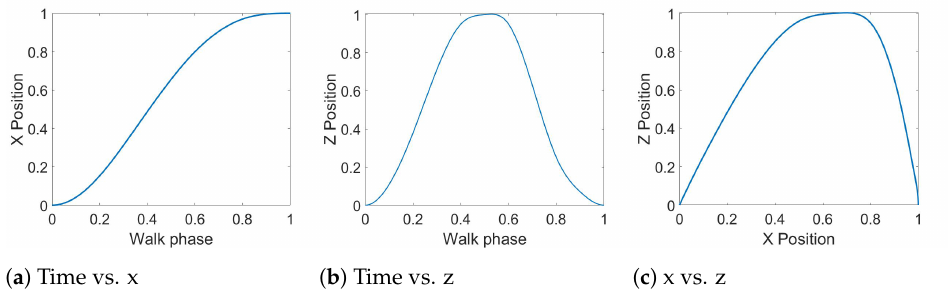
Figure 13. The reference foot